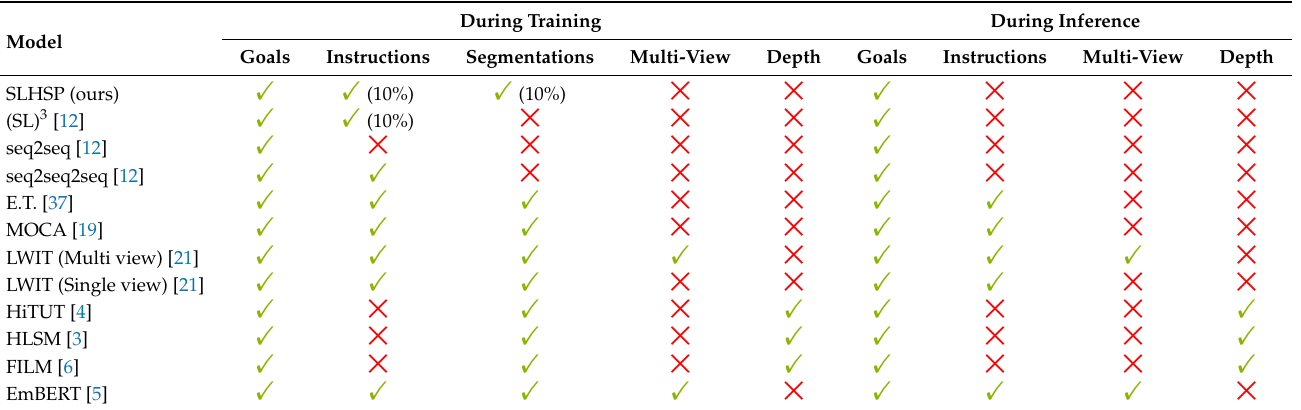
Table 1. Evaluated models in the experiments. (cid:33) denotes the use of corresponding attribute, and (cid:35) refers to the absence of corresponding